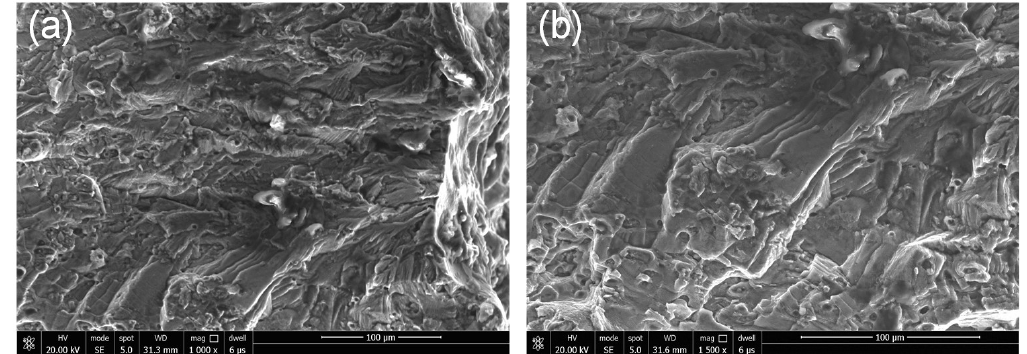
Figure 10. Typical fracture morphology of specimen without corrosion ( a ) crack initiation region, ( b ) cleavage characteristic.